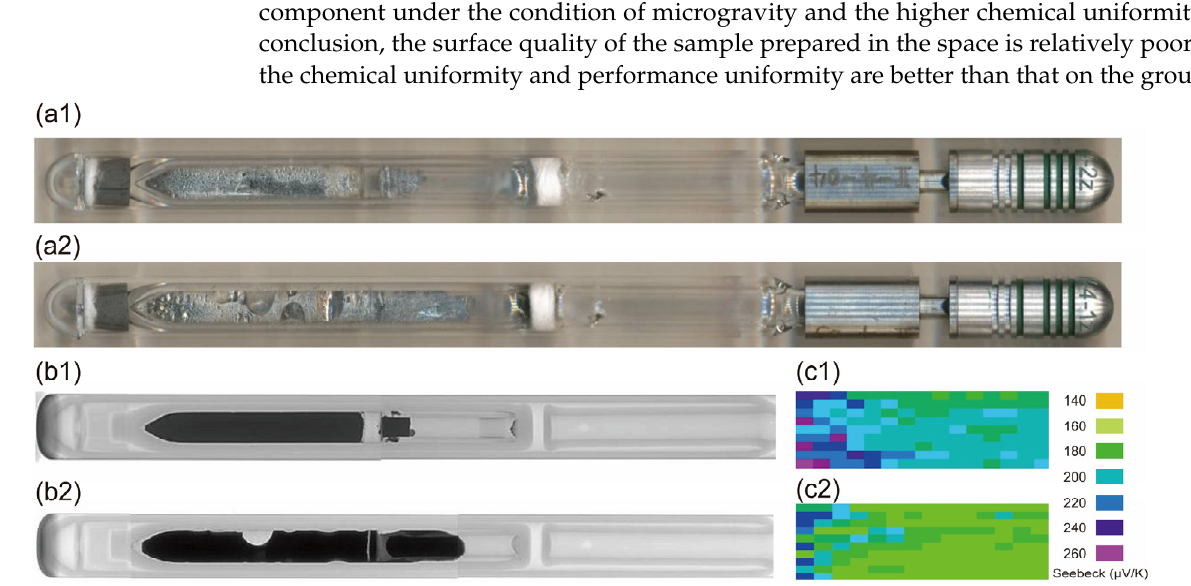
Figure 11. Comparison between bismuth telluride-based crystal materials prepared on ground and in space. ( a1 ) Morphology of the sample prepared on the ground, ( a2 ) Morphology of the sample prepared in the space, ( b1 ) CT result of the sample prepared on the ground, ( b2 ) CT result of the sample prepared in the space, ( c1 ) Seebeck coefficient distribution of the sample prepared on the ground, ( c2 ) Seebeck coefficient distribution of the sample prepared in the space.